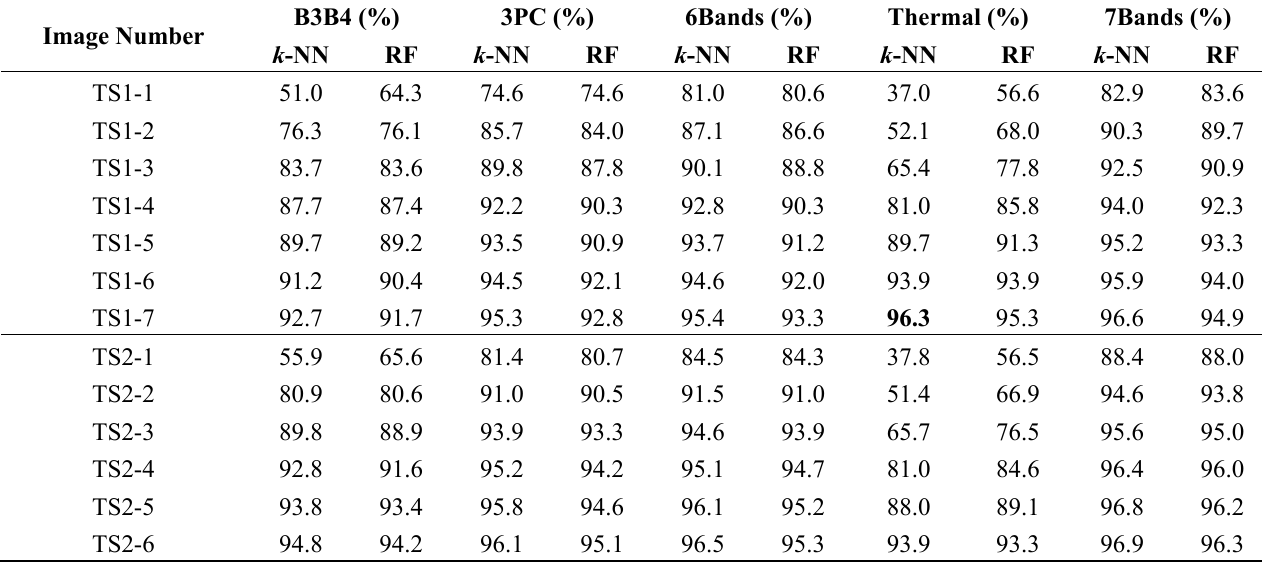
Table 8. Overall Accuracy of Level 2 classification by k -NN and Random Forest based on the time series images of the combination of band 3 and band 4 (B3B4), the first three principal components (3PC), the combination of 6 bands (6Bands), the thermal bands and the combination of 7 bands